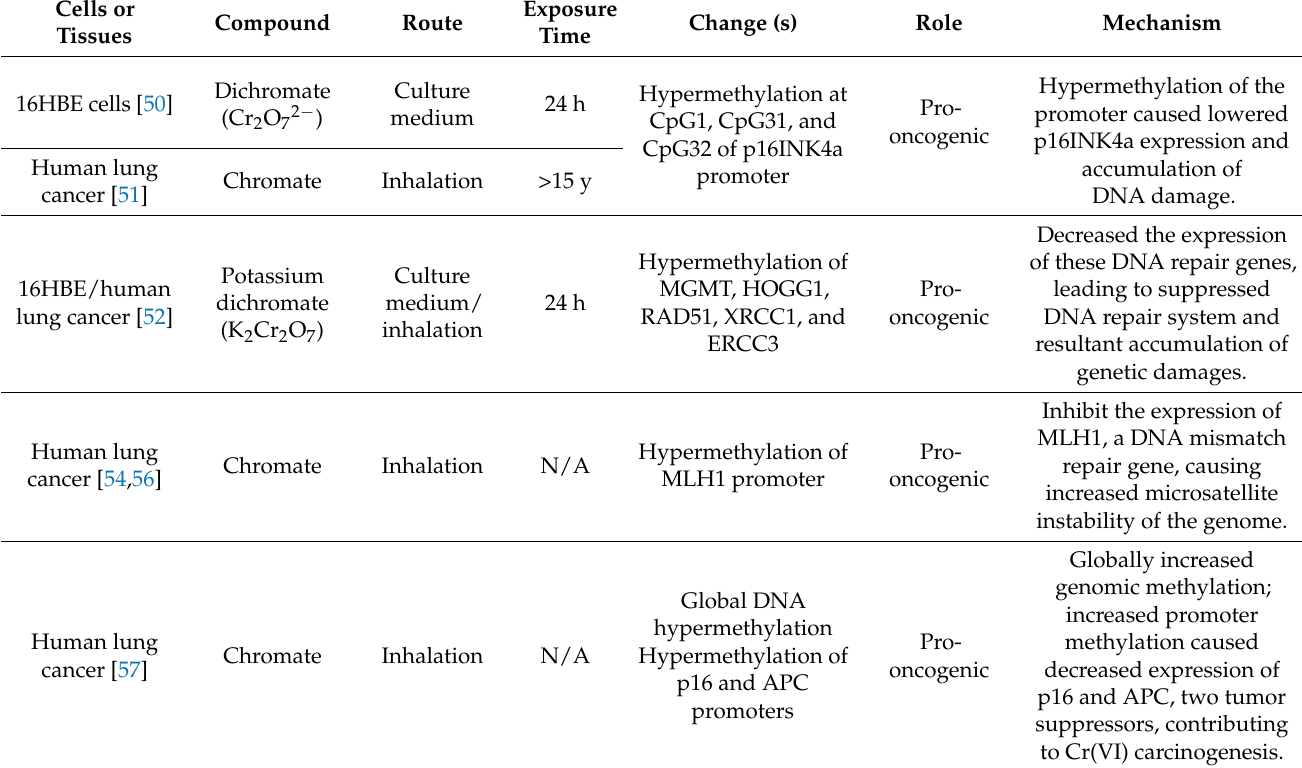
Table 1. Roles of altered DNA methylation in Cr(VI) exposure-induced